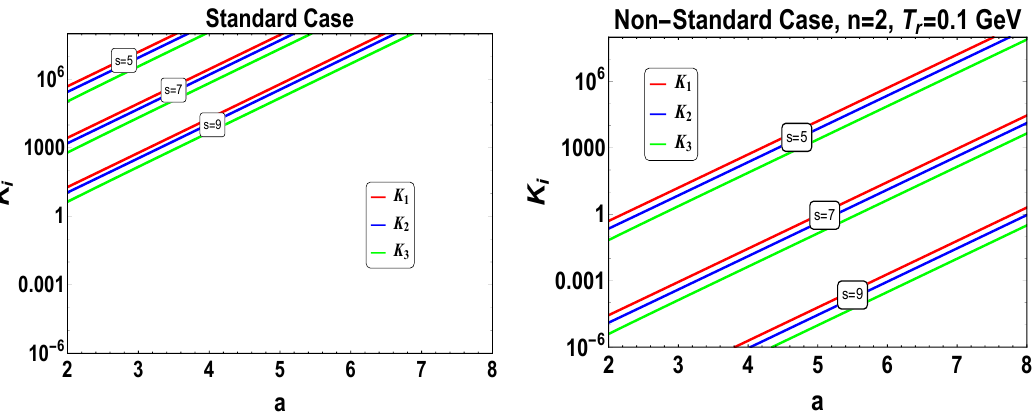
Figure 9 . Washout factors as a function of a for (left) standard and (right) non-standard case. We consider here M φ = { 10 s , 10 s +0 . 1 , 10 s +0 . 2 } GeV with s = { 7 , 8 , 9 } for the benchmark point I i